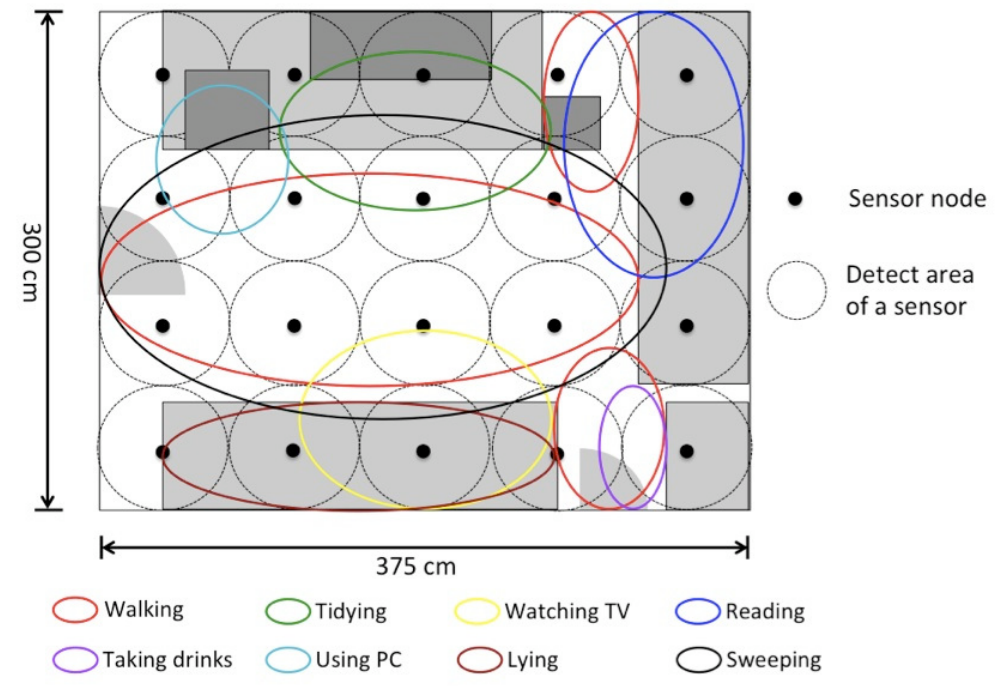
Figure 6. Areas associated with each activity. Different colors show different activities.